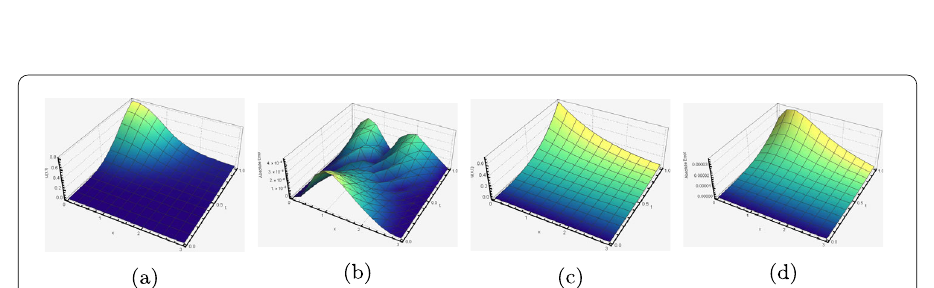
Figure 4 ( a ) and ( b ) represent approximate solution and absolute error distribution, respectively, using SJSCM. ( c ) and ( d ) represent approximate solution and absolute error distribution, respectively, using the